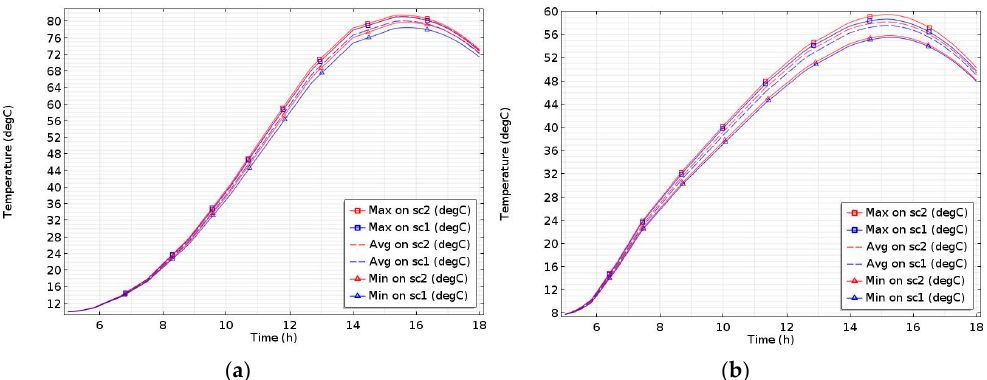
Figure 12. Temperature trend on the solar cells: ( a ) covered CPC system (17 July 2017); ( b ) uncovered CPC system (18 July 2017).